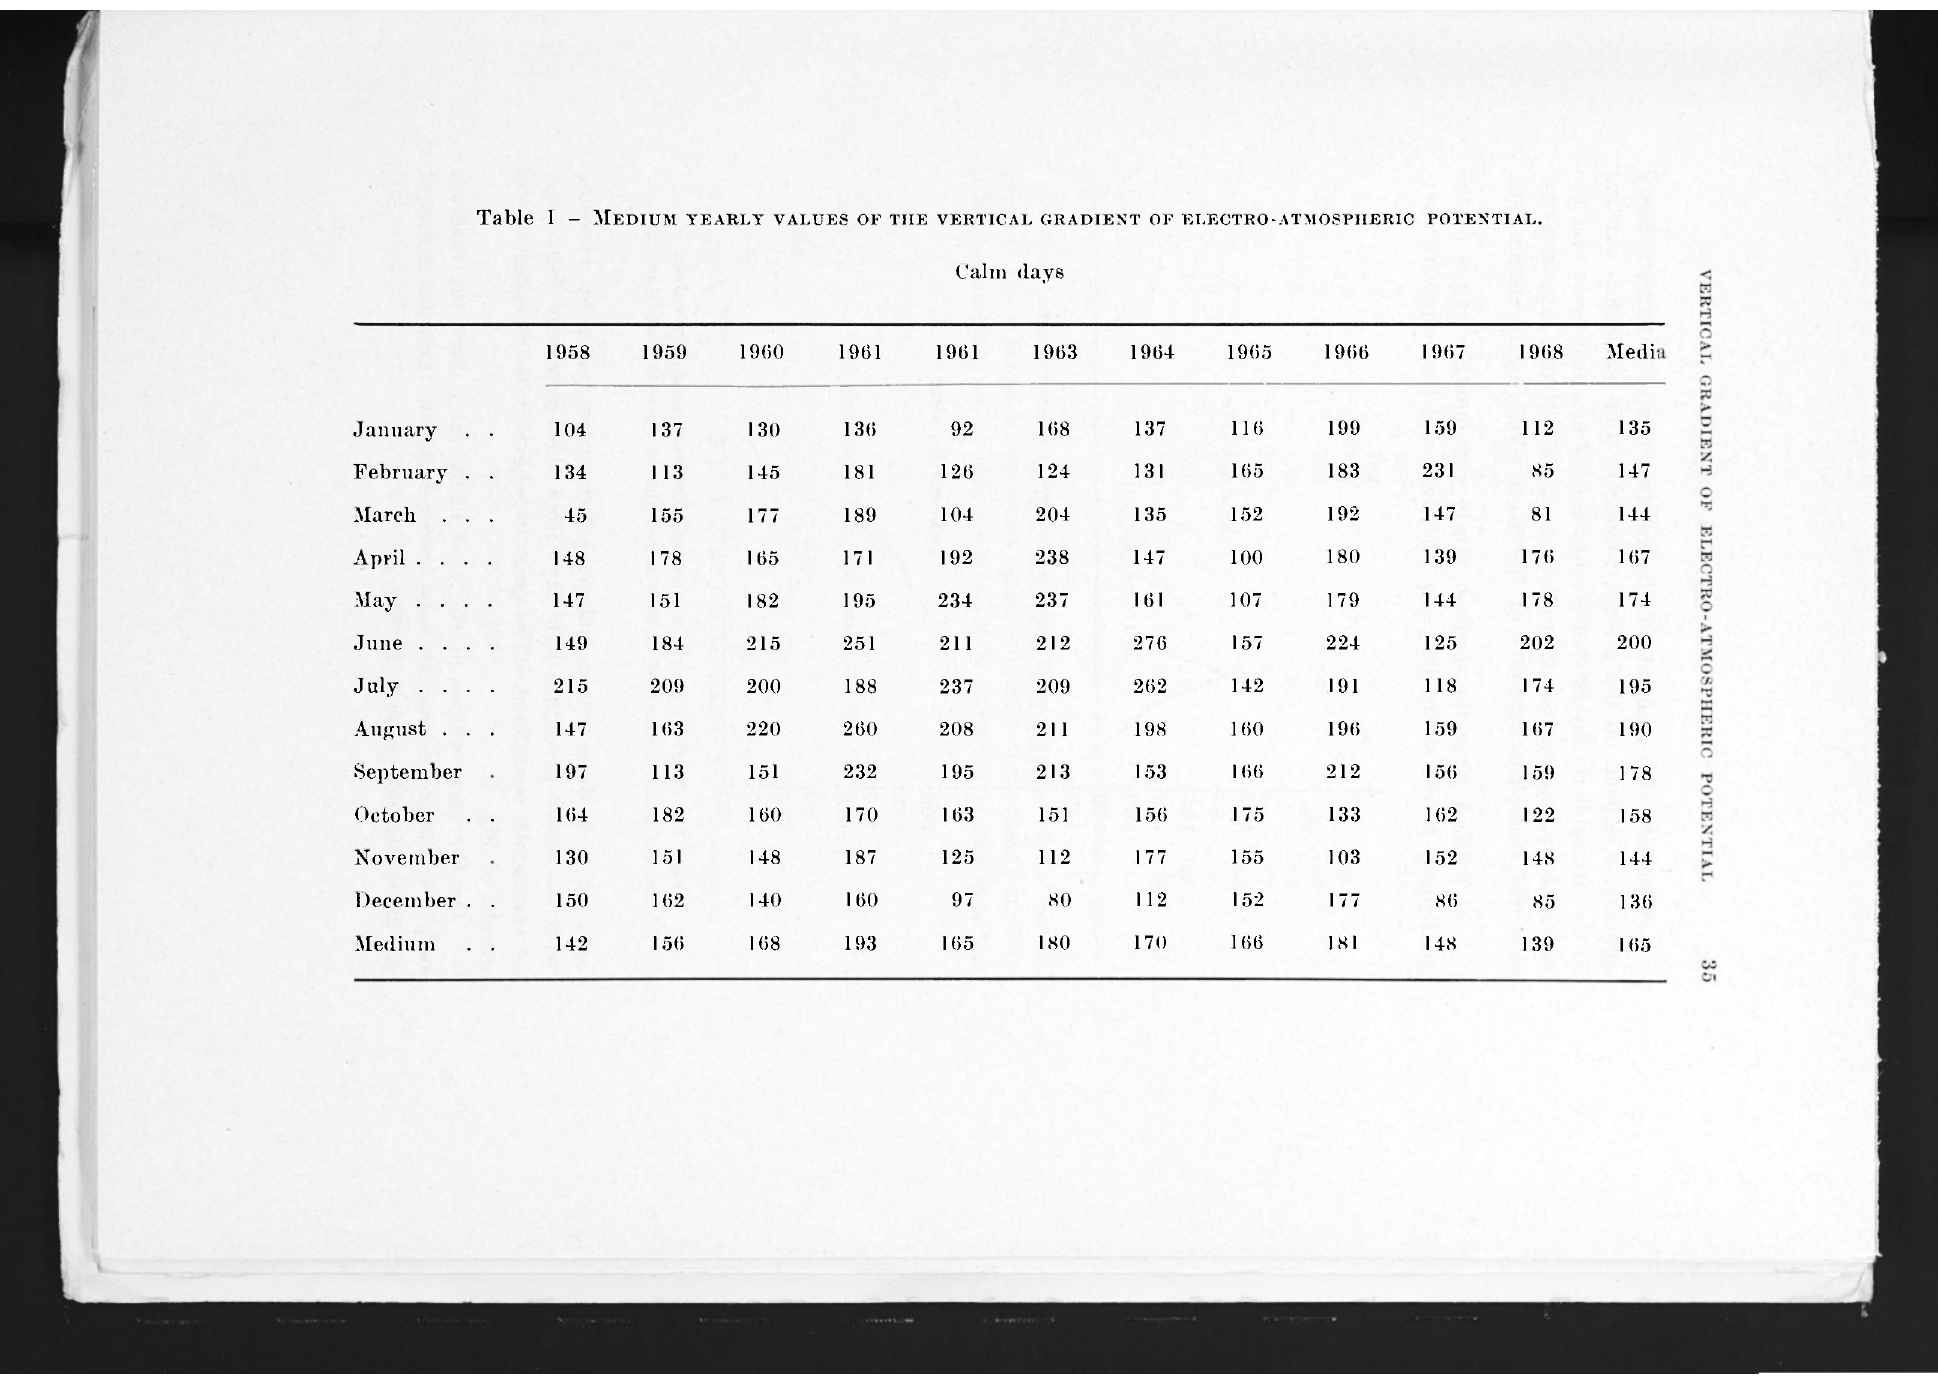
Table 1 - M E D I UM YEARLY VALUES OF THE VERTICAL GRADIENT OF ELECTRO-ATMOSPHERIC